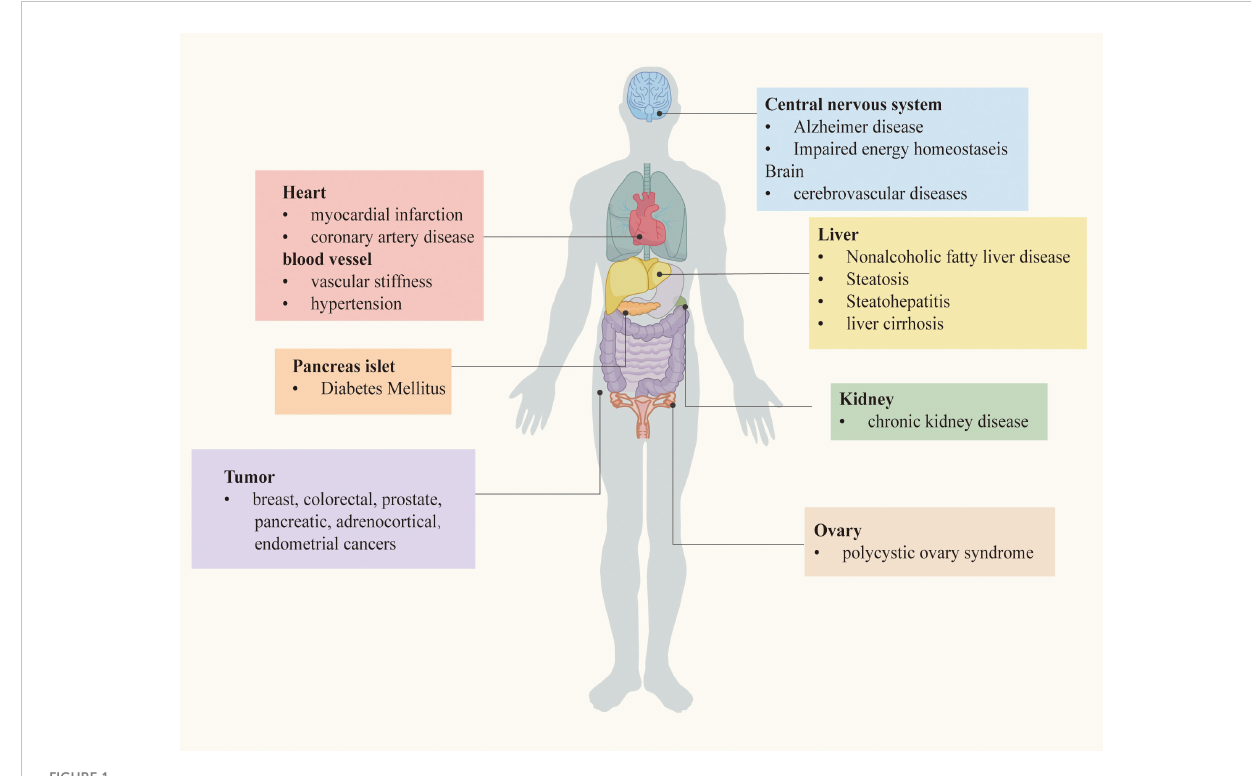
FIGURE 1 Chronic metabolic diseases may be induced by